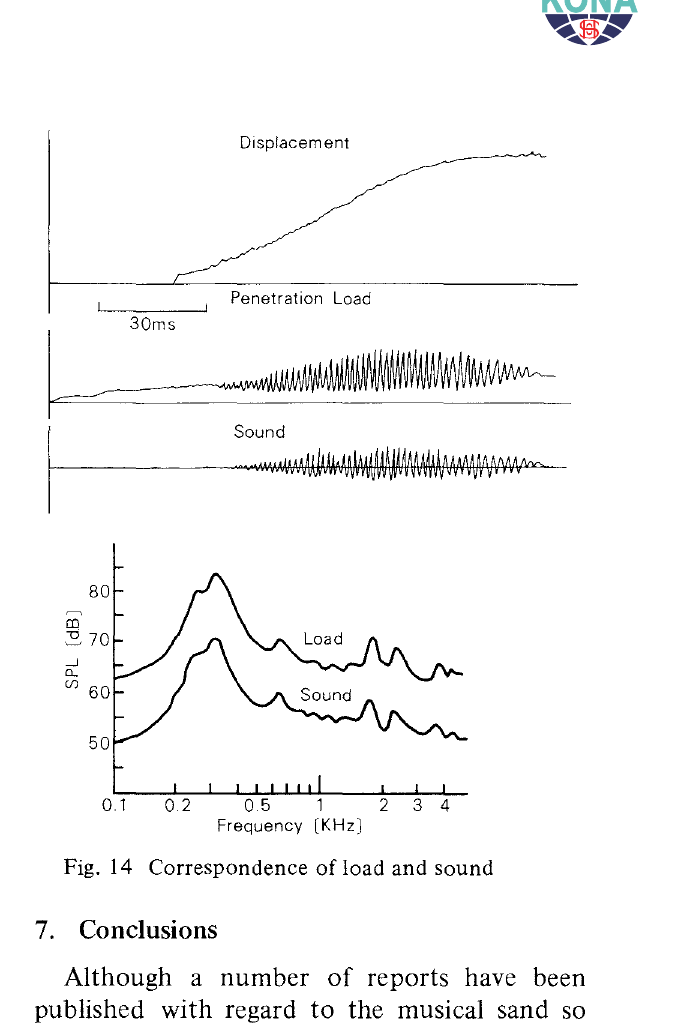
Fig. 14 Correspondence of load and